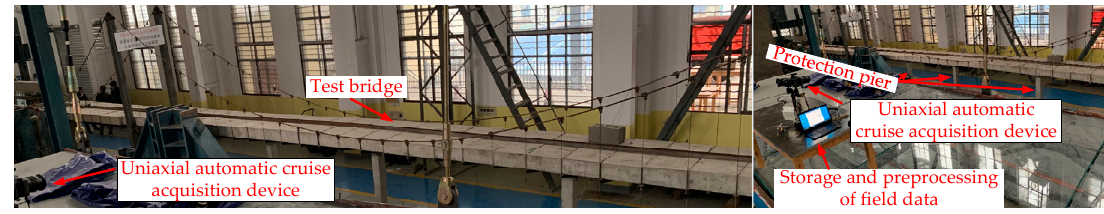
Figure 7. The layout of the lab.